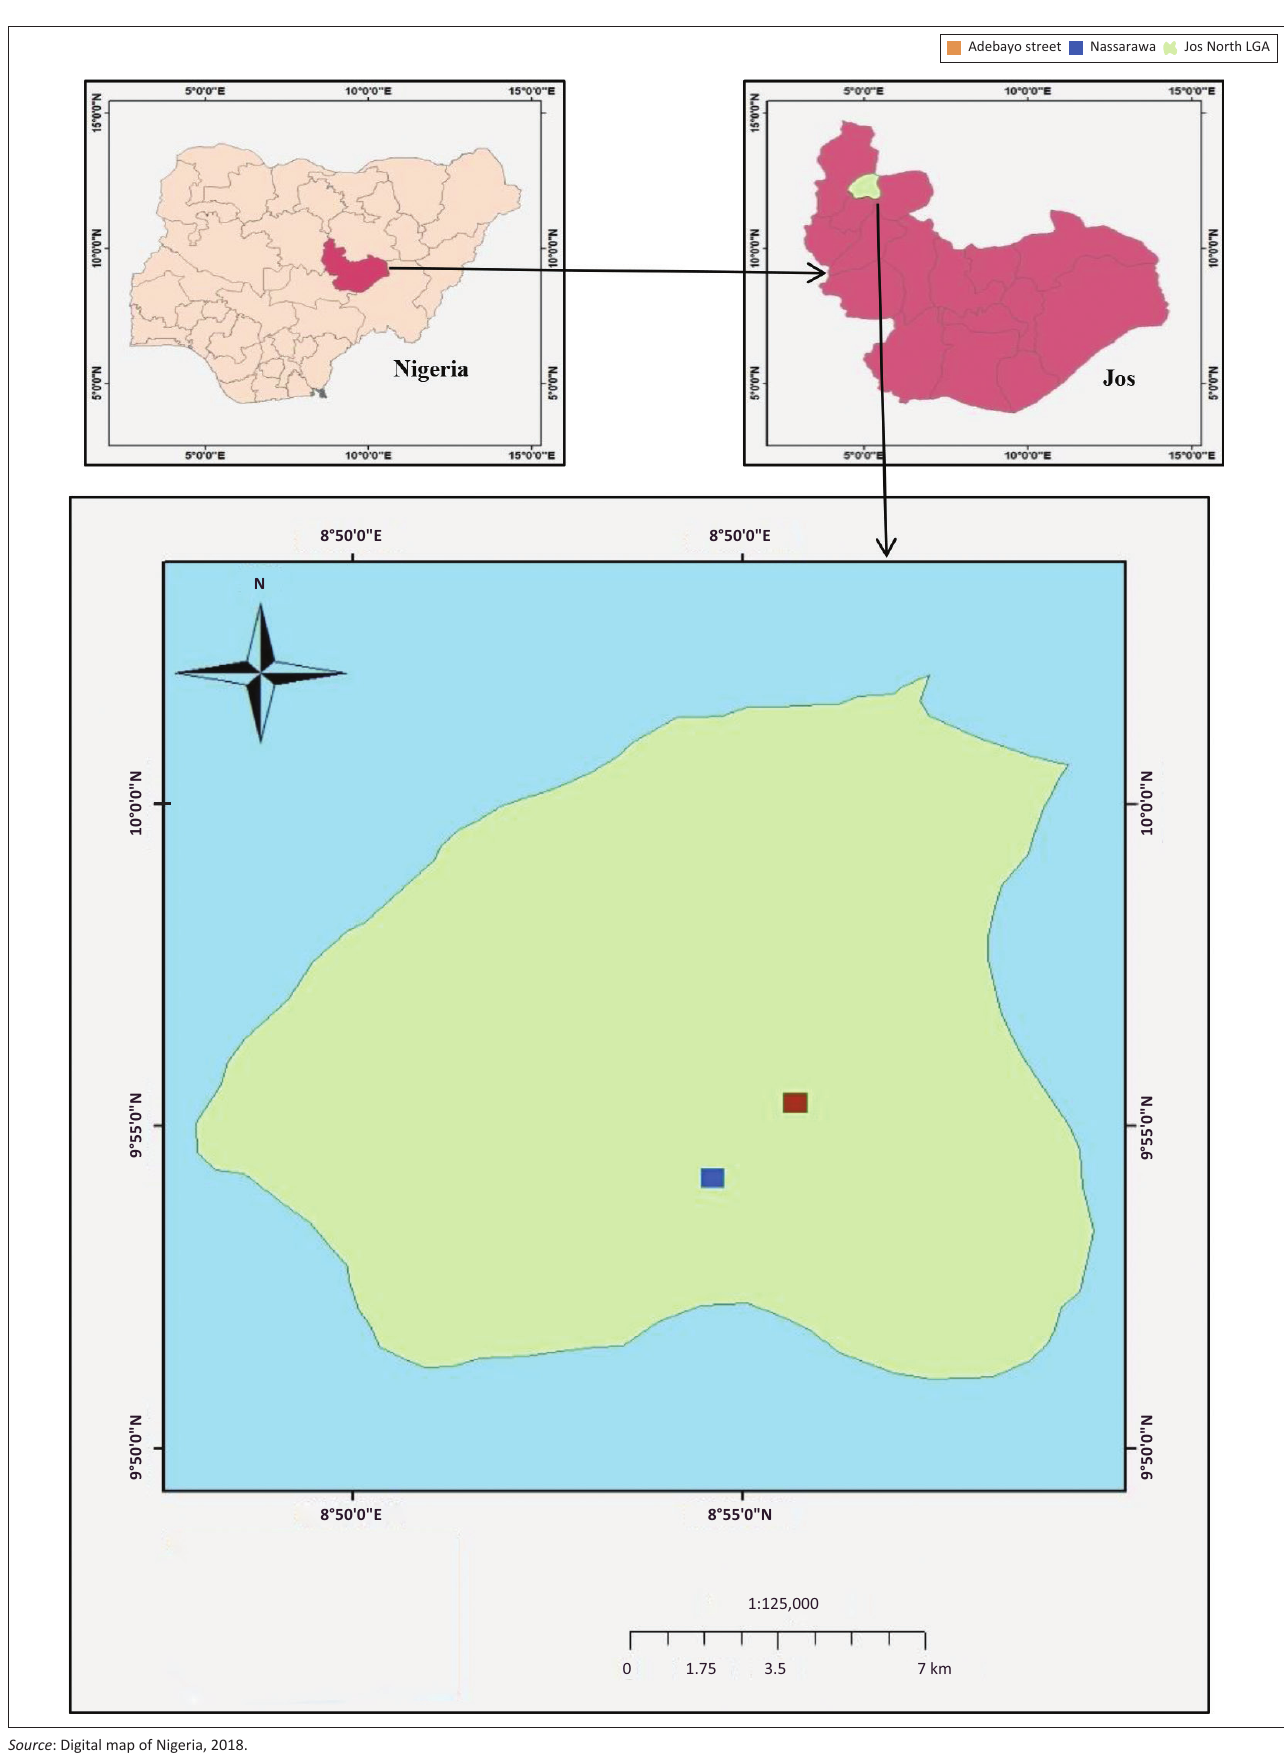
FIGURE 1: Map of Nigeria showing the location of research